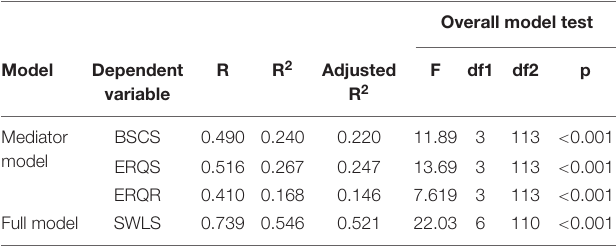
TABLE 2 | Fit measures and overall model tests for linear regression models included in the mediation analysis, which estimates indirect, direct and total effects of karate training on satisfaction with life, with self-control, suppression, and reappraisal as mediating variables, and with gender and dichotomized age as covariates.